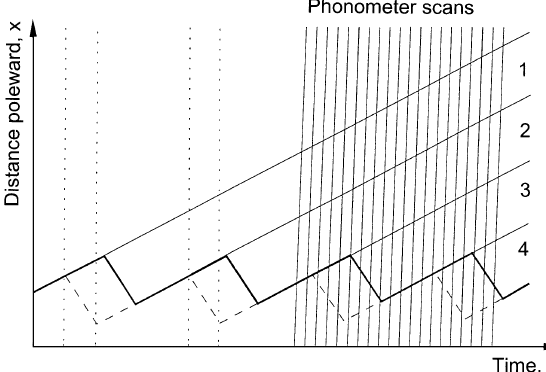
Fig. 4. Same as Fig. 1b, but showing the locus of a photometer beam at a fixed altitude which scans polewards along the meridian every 20 s